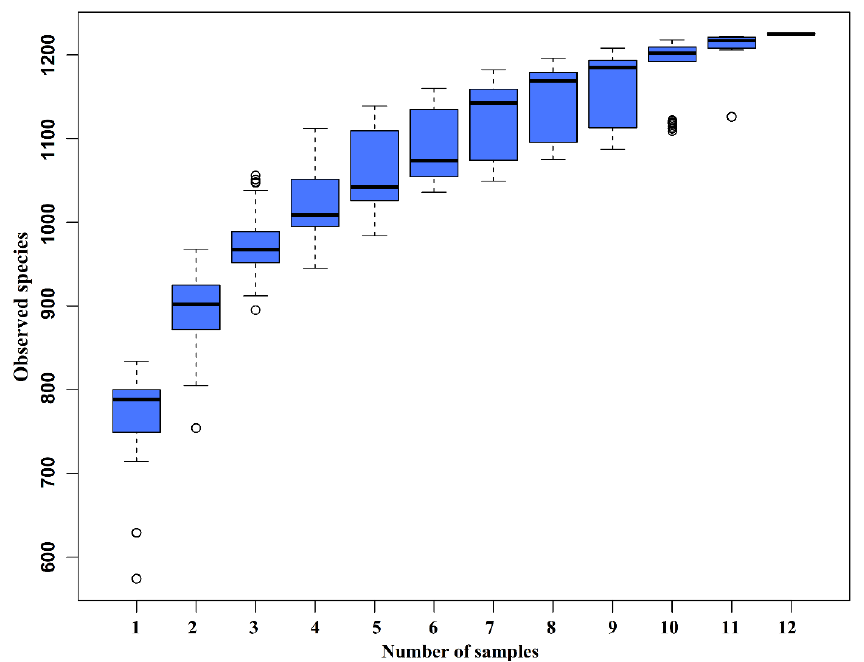
Figure 2. Species accumulation curves (SAC). The SAC tends to flatten as the number of analyzed sequences increases up to 12, indicating that our samples were sufficient for OTU testing and could predict the species richness of samples.